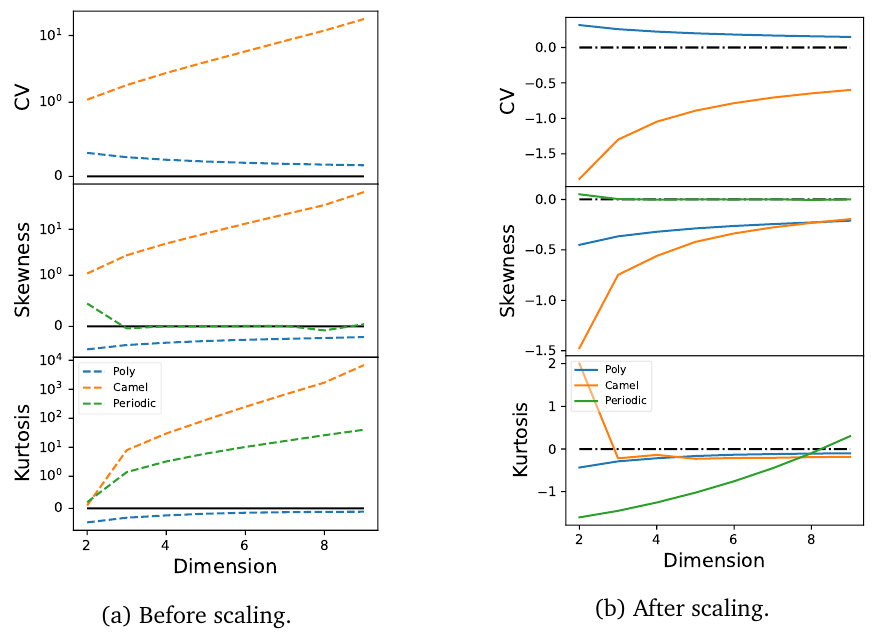
Figure 3: Three data statistics: coefficient of variation, skewness, and kurtosis in various dimensions for the polynomial, Camel, and periodic